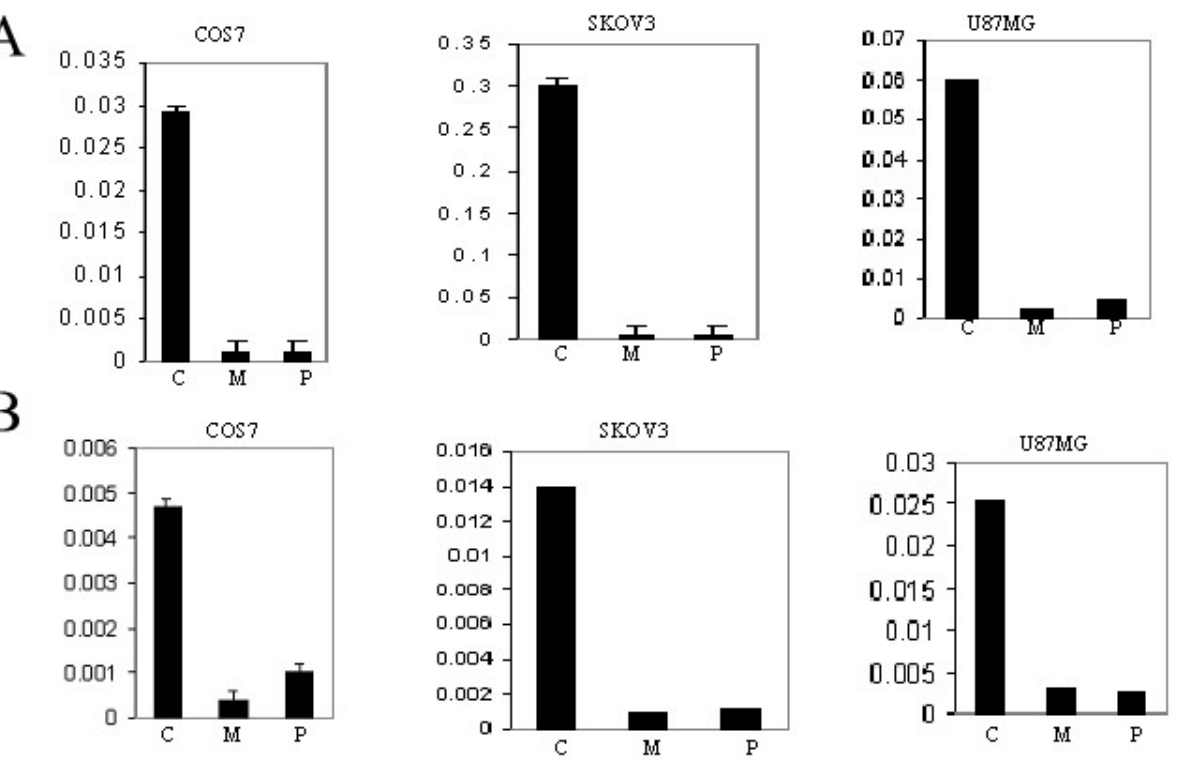
Figure 5. The effect of promoter methylation on the expression of luciferase reporter gene. ( A ) P NN promoter containing construct was transfected into SKOV3, U87MG, and COS7 cells before and after methylation. The reporter gene expression was quantified by measuring the luminescence. ( B ) P N promoter containing construct was transfected into SKOV3, U87MG, and COS7 cells before and after methylation. The reporter gene expression was quantified by measuring the luminescence, and the data represent mean + standard deviation of triplicate measurements. The Y -axis indicates relative luciferase activity (RLA) units. C, mock treated promoter; M, methylated promoter; P, empty pGL3 vector.